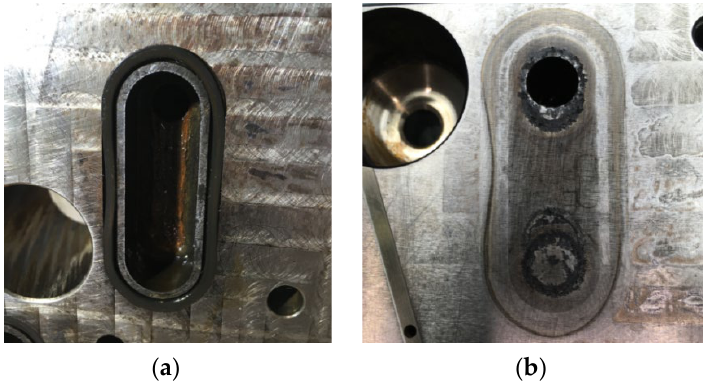
Figure 14. ( a ) Injection molding tool with the O-ring affected; ( b ) Traces generated by bad assembly of O-ring.